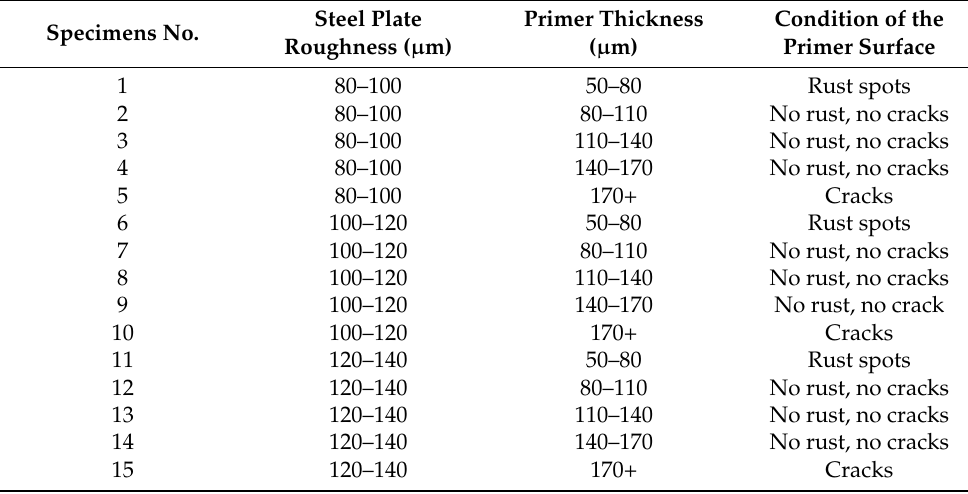
Figure 17. Cracks on the surface of the no-WBM specimen with a primer thickness of 170+ μ m. Table 13. Primer surface conditions of the no-WBM specimens. Specimens